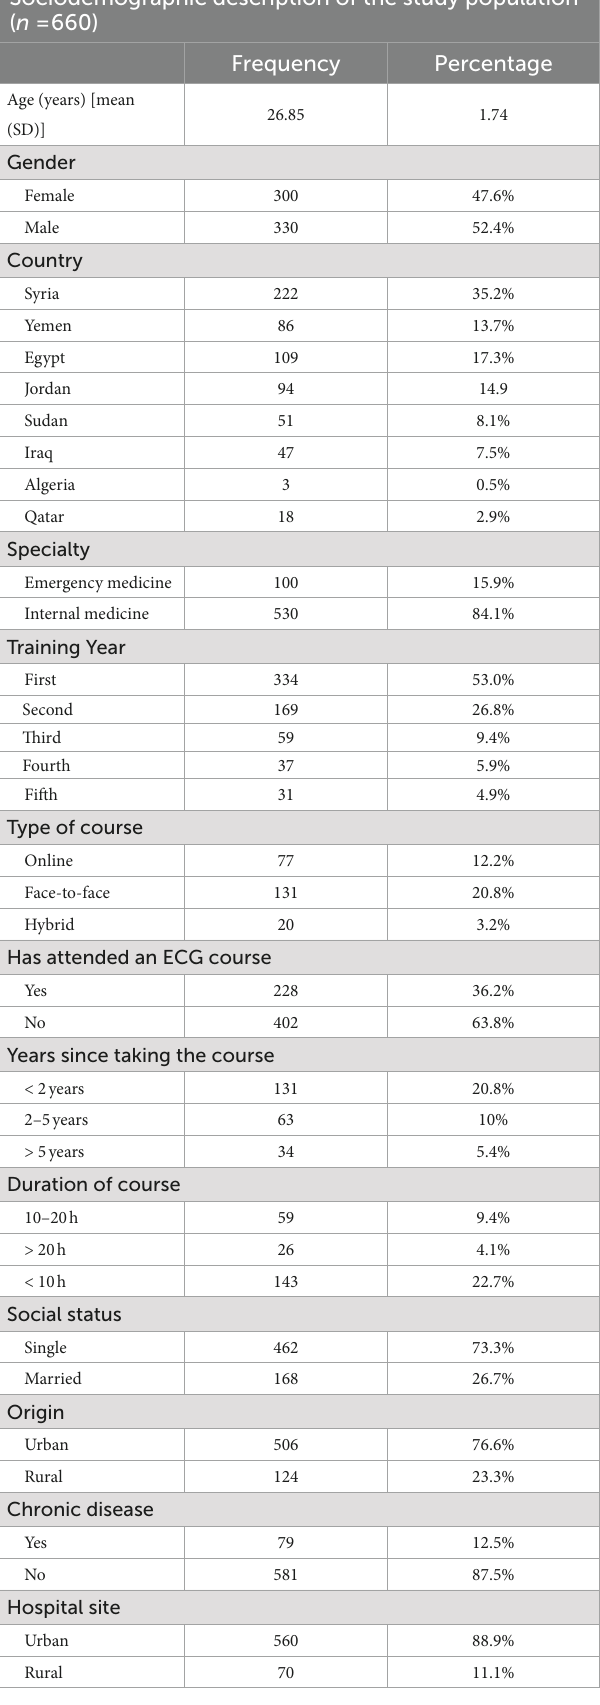
TABLE 1 Socio-demographic features of the study participant. Sociodemographic description of the study population ( n =